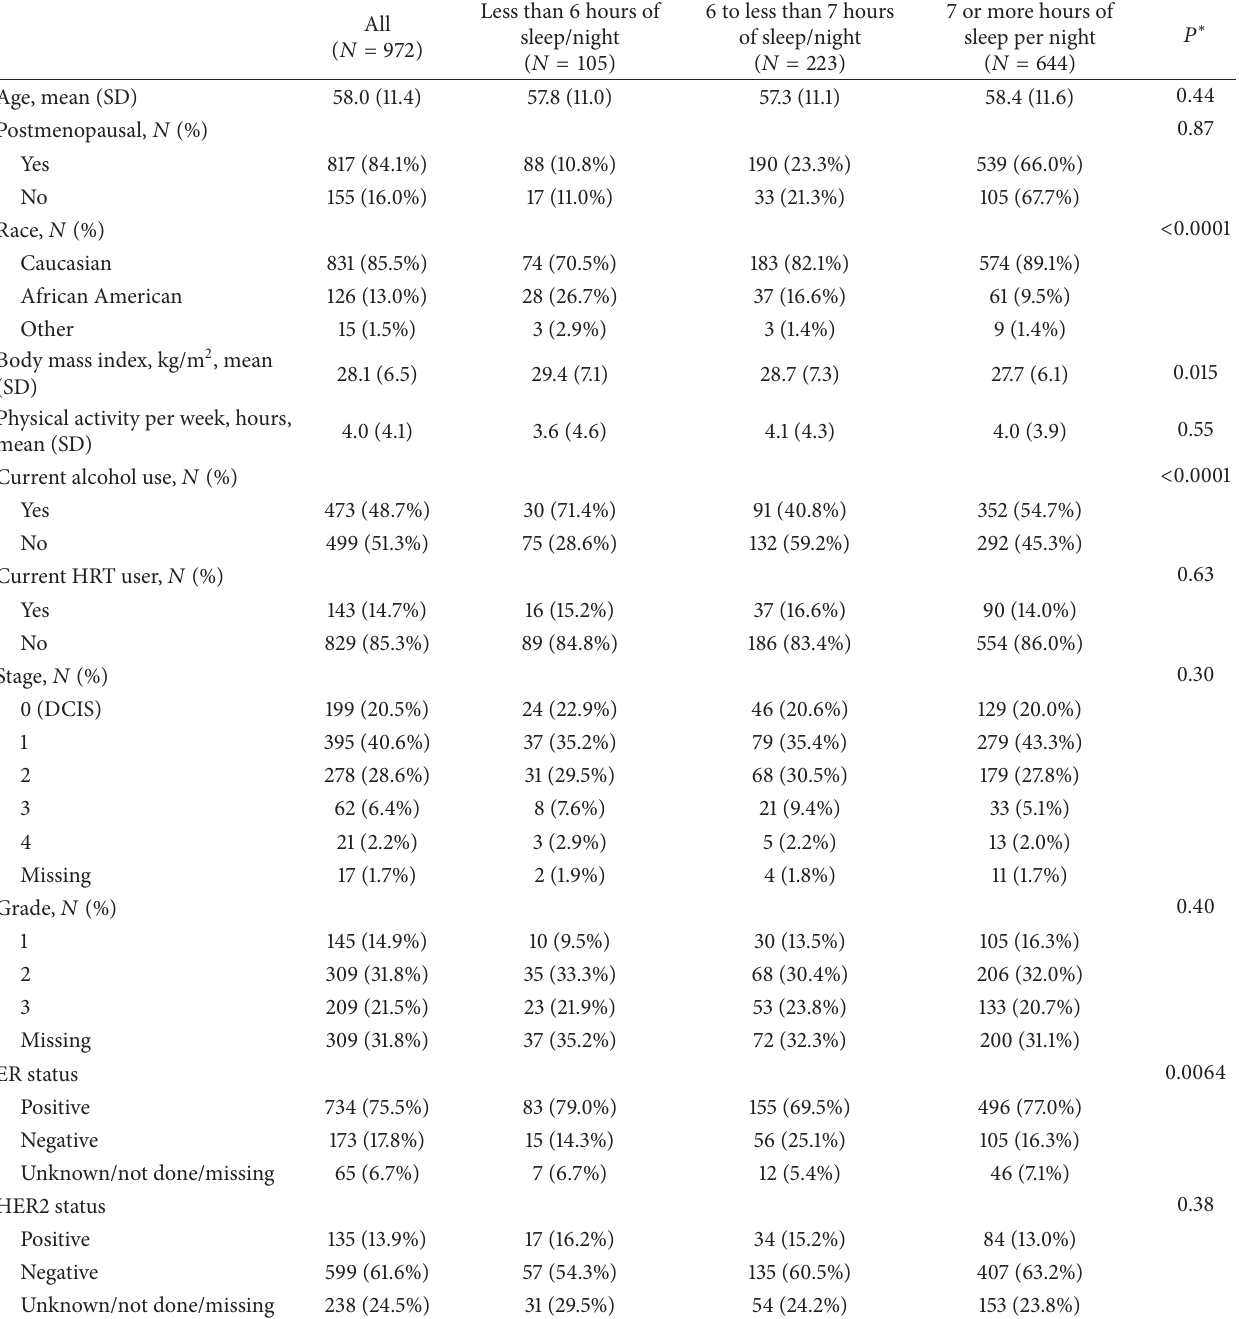
Table 1: Patient characteristics by category of average hours of